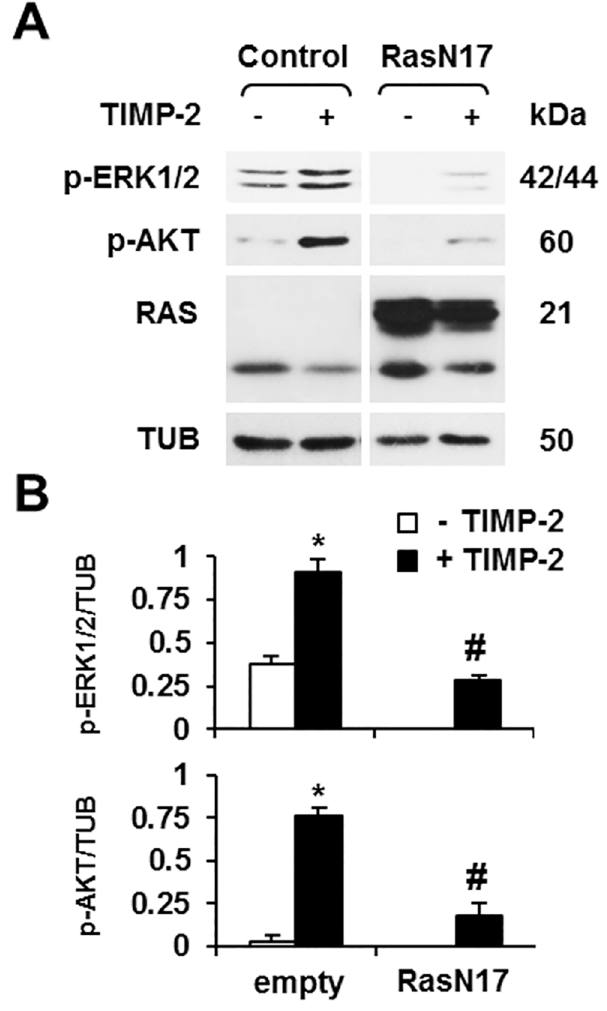
Fig 6. TIMP-2 activation of both ERK 1/2 and AKT is mediated by Ras. A . MT1-MMP-expressing Tet-Off MCF-7 cells transiently transfected with RasN17 cDNA or control, empty vector were incubated with TIMP-2 (100 ng/ml) for 15 min. Cell extracts were analyzed by Western blotting for ERK1/2 and AKT activation (p- ERK1/2; p-AKT), and for RasN17 expression using β -tubulin (TUB) as a loading control. B. Densitometric analysis. * , p (cid:1) 0.05, + TIMP-2 vs . the corresponding – TIMP-2 sample; # RasN17 vs . the corresponding empty vector control. This experiment was repeated three times with comparable